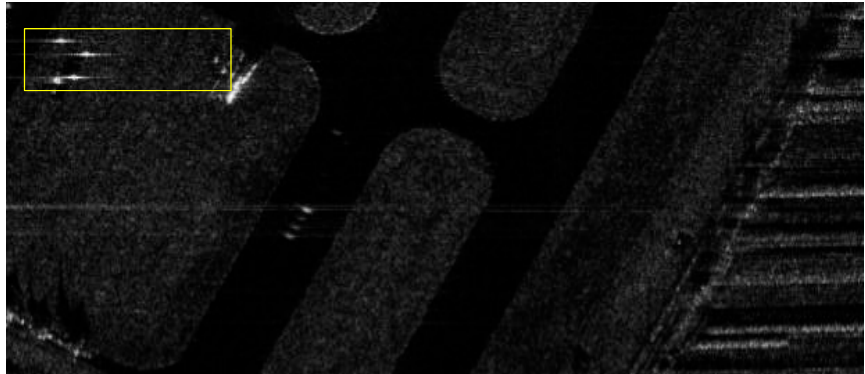
Figure 8. SAR images processed by conventional piecewise STAP.